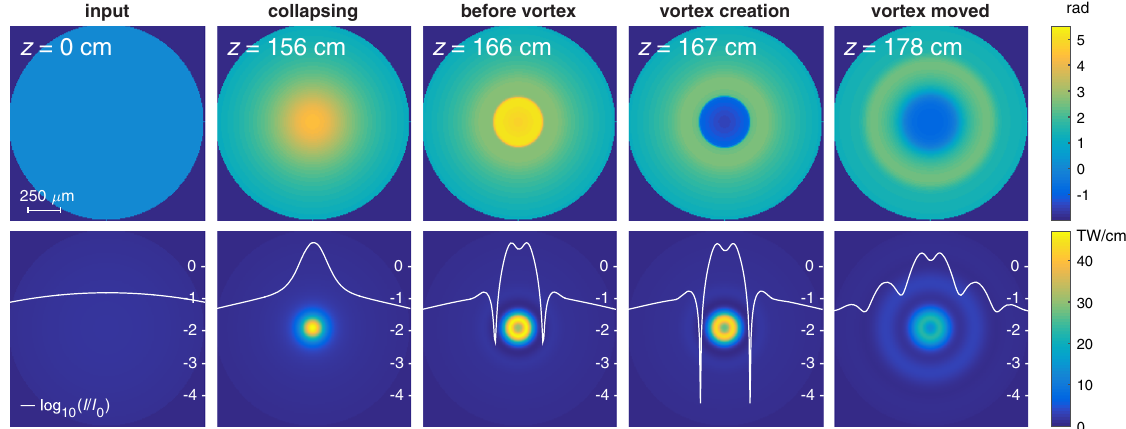
FIG. 3. Simulations of beam phase (top) and intensity (bottom) at the axial or temporal slice ξ From left to right, the pulse is advancing along z , with the input shown at z ¼ 0 , a collapsing beam at z ¼ 156 cm, ionization onset at 160 cm (not shown), just before the vortices spawn at 166 cm, just after the vortices spawn at 167 cm, and an image where the vortex pair has moved out of the ξ ¼ ξ plane. The linear intensity images are overlaid with centered lineouts of log 10 ð I=I 0 Þ , where v I 0 ¼ 10 13 W = cm 2 . Experimental parameters are used as code inputs: w 0 ¼ 1 . 3 mm, pulse energy 2.8 mJ ( P=P FWHM 45